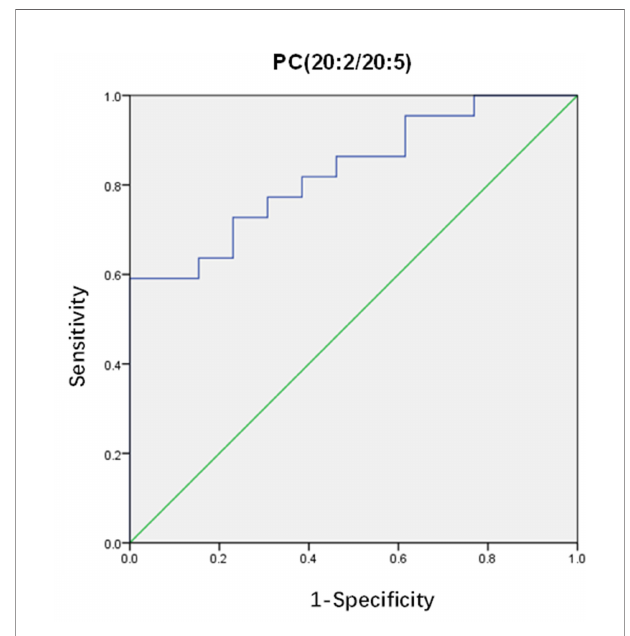
FIGURE 4 | Receiver operating characteristic curve for